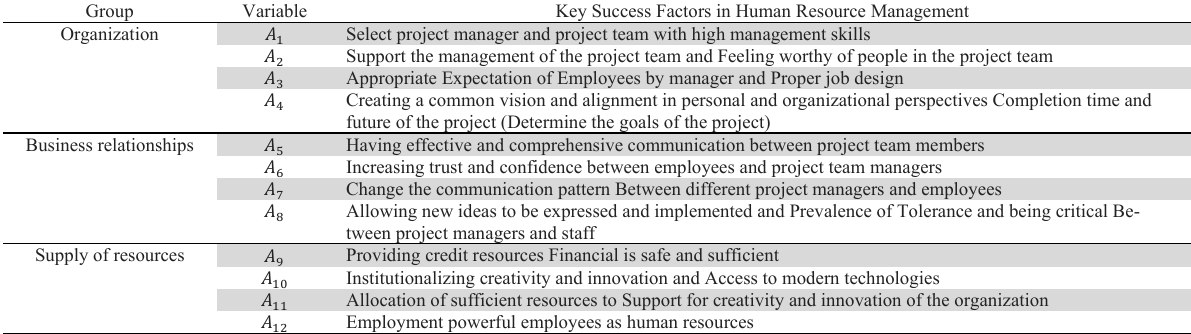
Construction project valuation key success factor